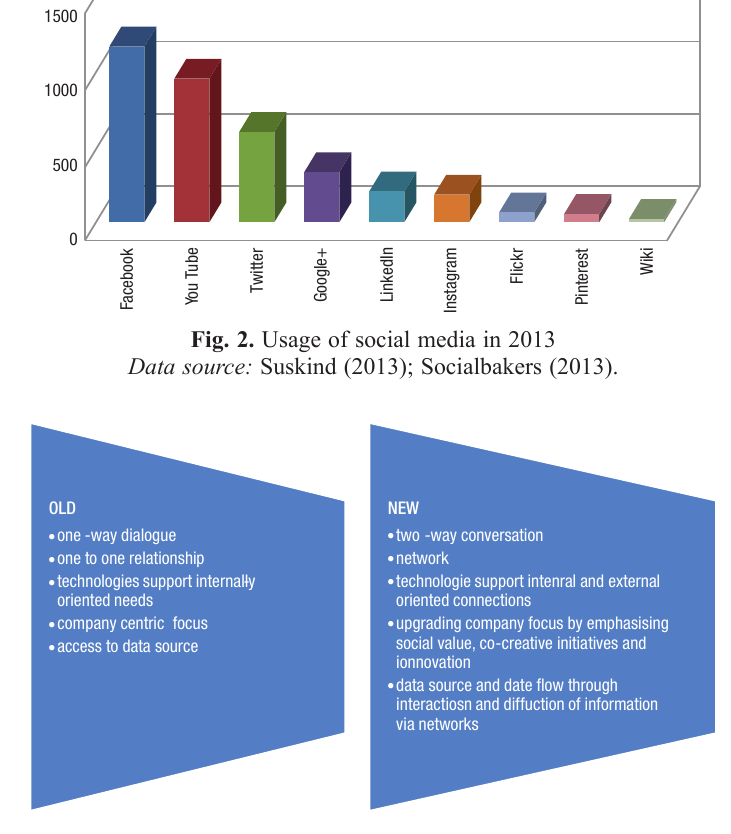
Fig. 3. Changes in communication capabilities due to social media